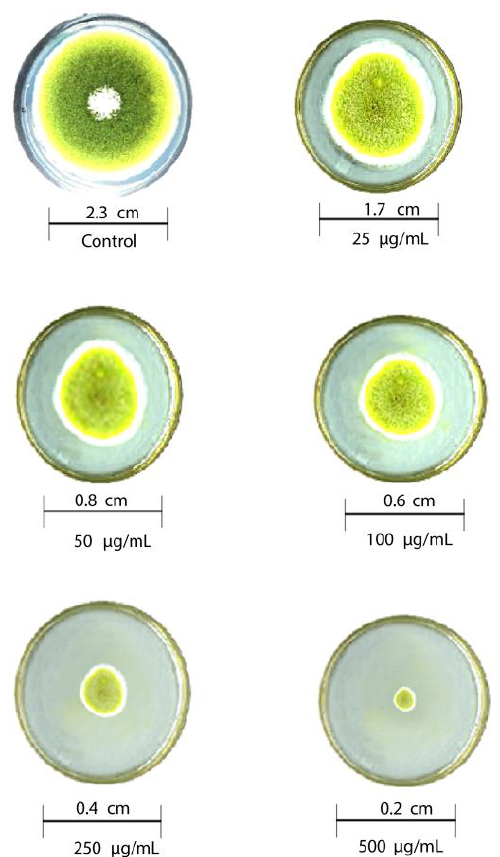
Figure 6. Antifungal activity of T-rGO nanosheets: mycelial growth of Aspergillus flavus on the PDA media containing different concentrations of reduced graphene oxide (25 – 500 µg/mL).